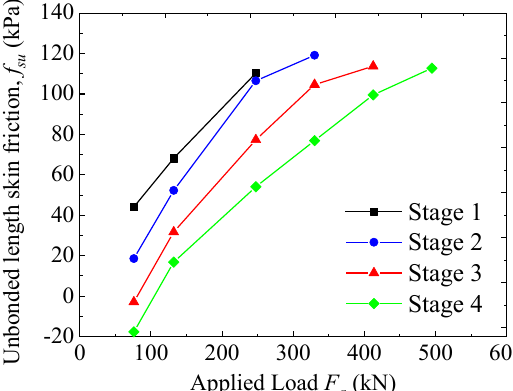
Figure 16 - Calculated skin friction on the unbonded length of ground anchor T33 during loading stages of the suitability test.